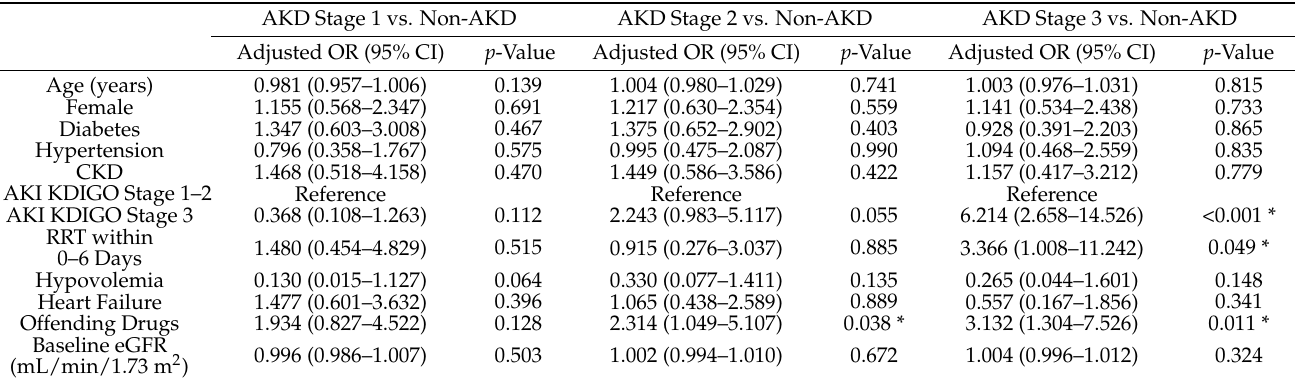
Table 4. Independent predictors of AKD severity in patients with AKI.